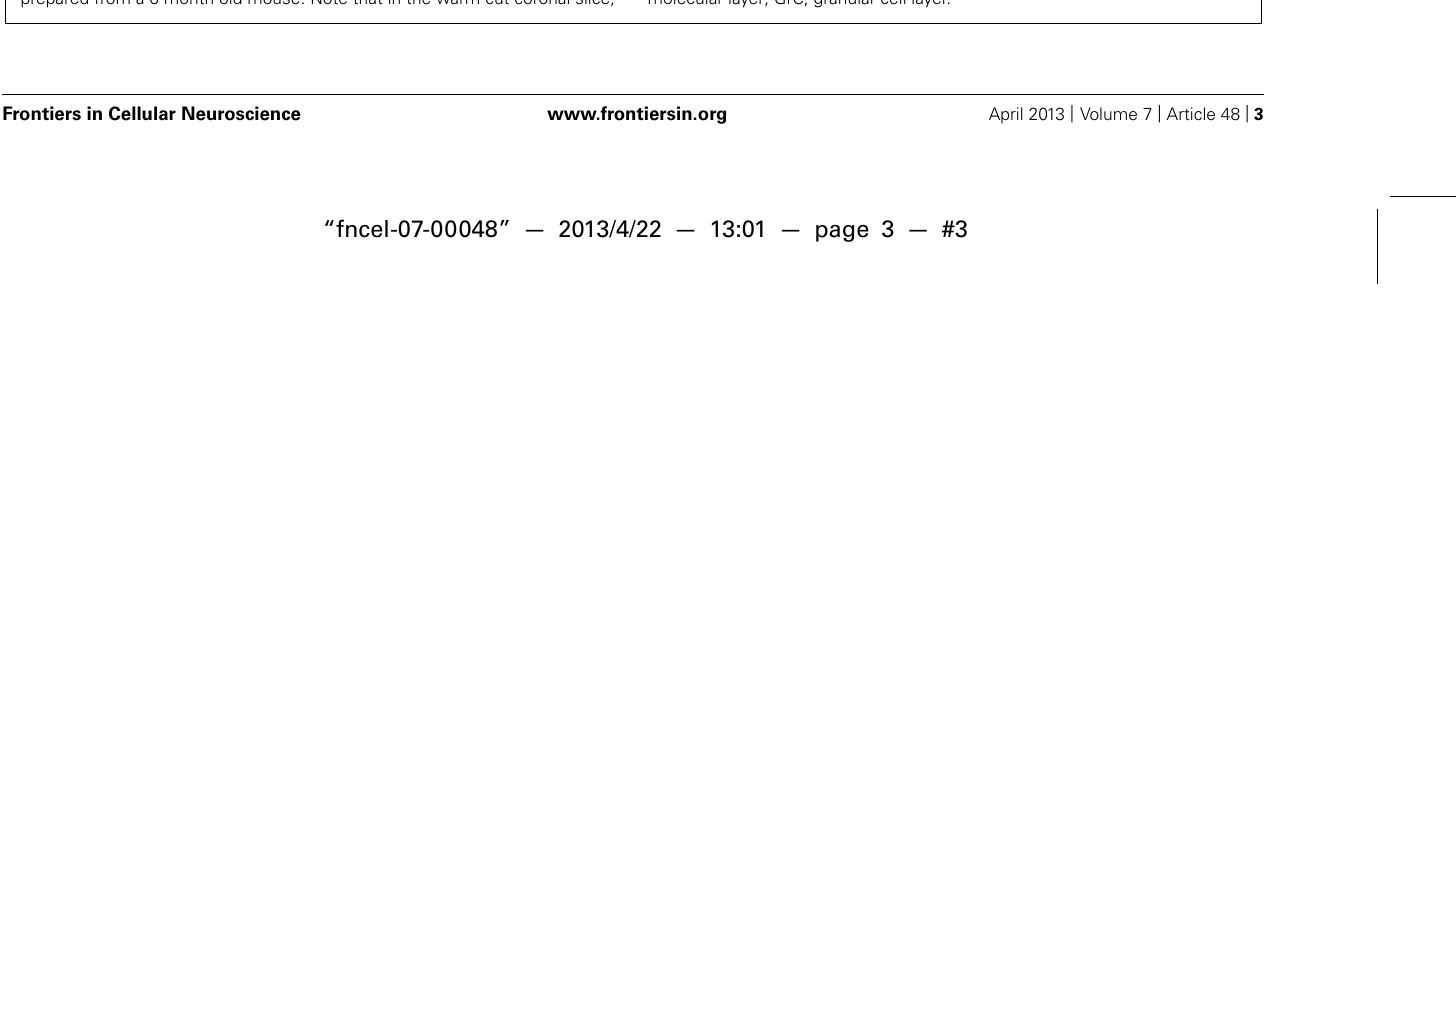
DCN cell bodies of both small (labeled “ + ”) and large (“*”) sizes are visible; in cold-cut coronal slices from old animals, most cells were small (labeled “ + ”). In cold-cut sagittal slices, hardly any healthy neurons in the Purkinje layer were found. In contrast, numerous patchable Purkinje neurons are easily seen in the warm-cut sagittal section. PN, Purkinje neuron layer; ML, molecular layer; GrC, granular cell